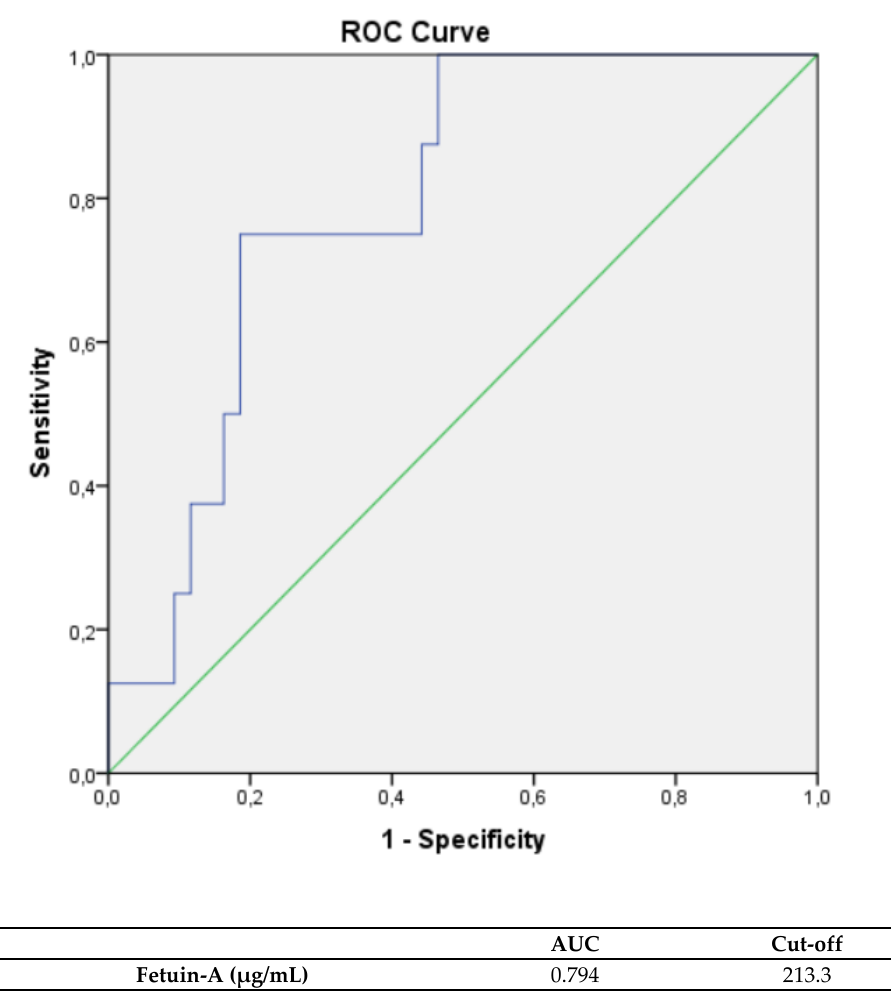
Figure 2. ROC curves and cutoff scores for fetuin-A for prediction of arrhythmic events in the total cohort.